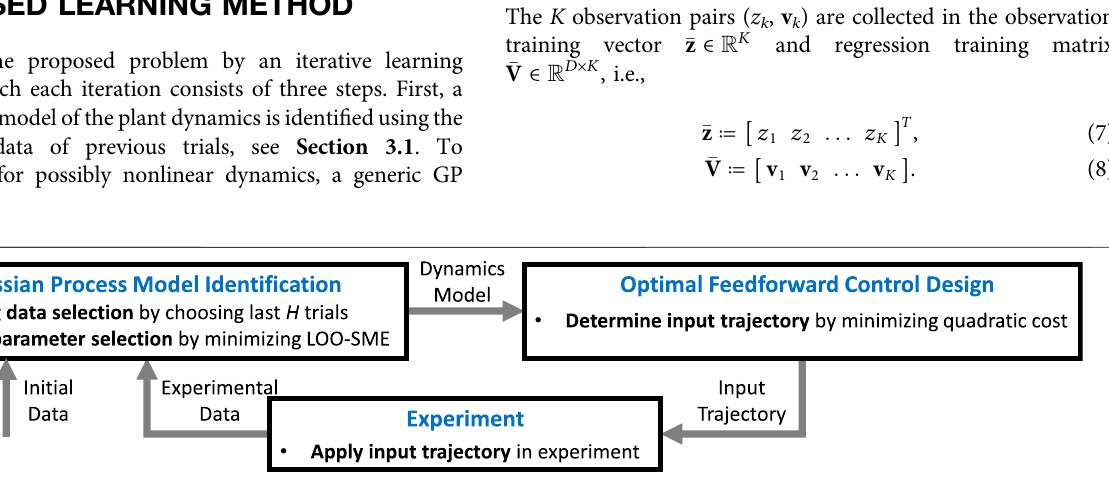
FIGURE 3 | Overview of the proposed learning method: First a Gaussian Process (GP) model is identi fi ed, which in turn is used to determine an input trajectory via optimization. The resulting input trajectory is applied in experiment yielding new data to re fi ne the GP model.